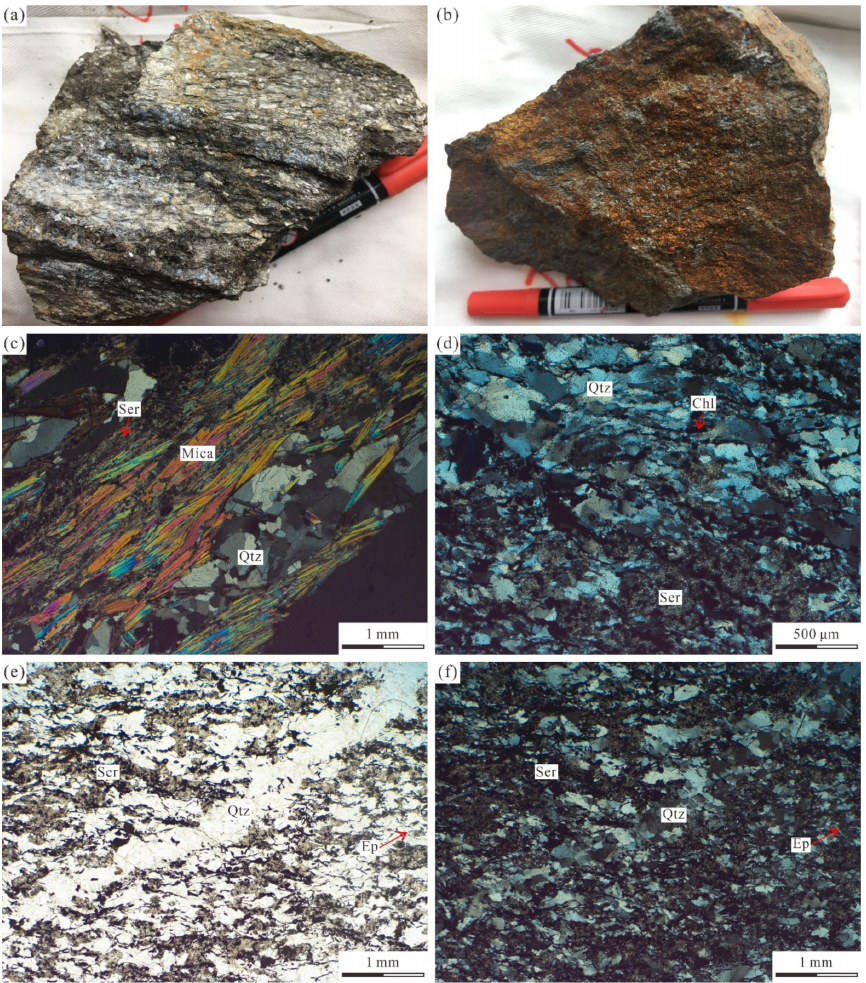
Figure 6. Representative hand specimen ( a , b ) and photomicrographs ( c – f ) of gangue minerals from the Baishitouwa deposit. ( a , b ) Mica schist. ( c ) Mica and quartz in mica schist. Sericitization (crossed-polarized light). ( d ) Silicification, chloritization, and sericitization (crossed-polarized light). ( e ) Silicification, epidotization, and sericitization (plane-polarized light). ( f ) Silicification, epidotiza- tion, and sericitization (crossed-polarized light). Abbreviations: Qtz, quartz; Ser, sericite; Chl, chlorite; Ep,